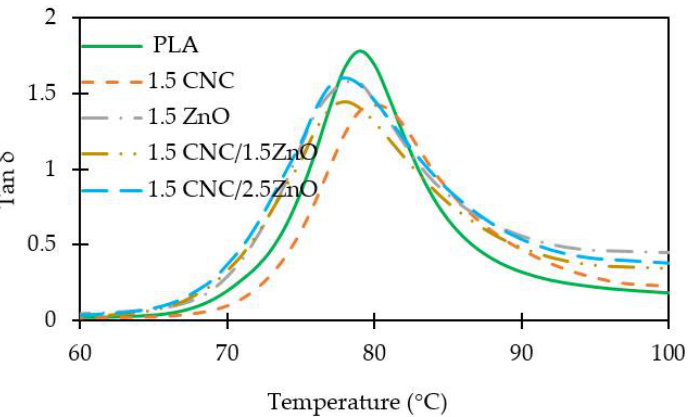
Figure 5. Representative curve of tanδ as a function of temperature for PLA nanocomposites rein- forced with CNC and ZnO.